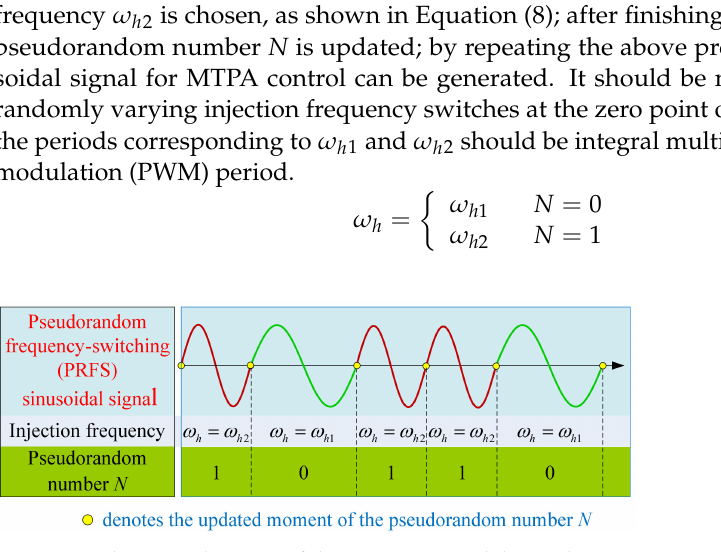
Figure 2. Schematic diagram of the PRFS sinusoidal signal